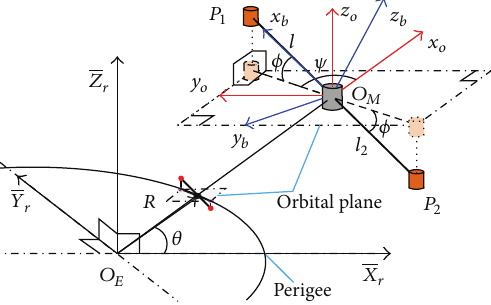
Figure 3: The coordinate systems.